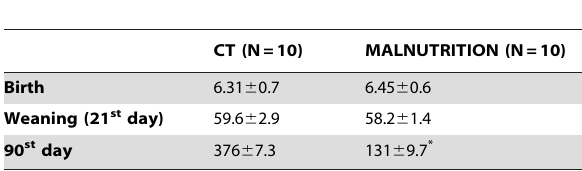
Table 2. Body weight (g) measurements of control (CT) and post-weaning protein malnutrition (Malnutrition)